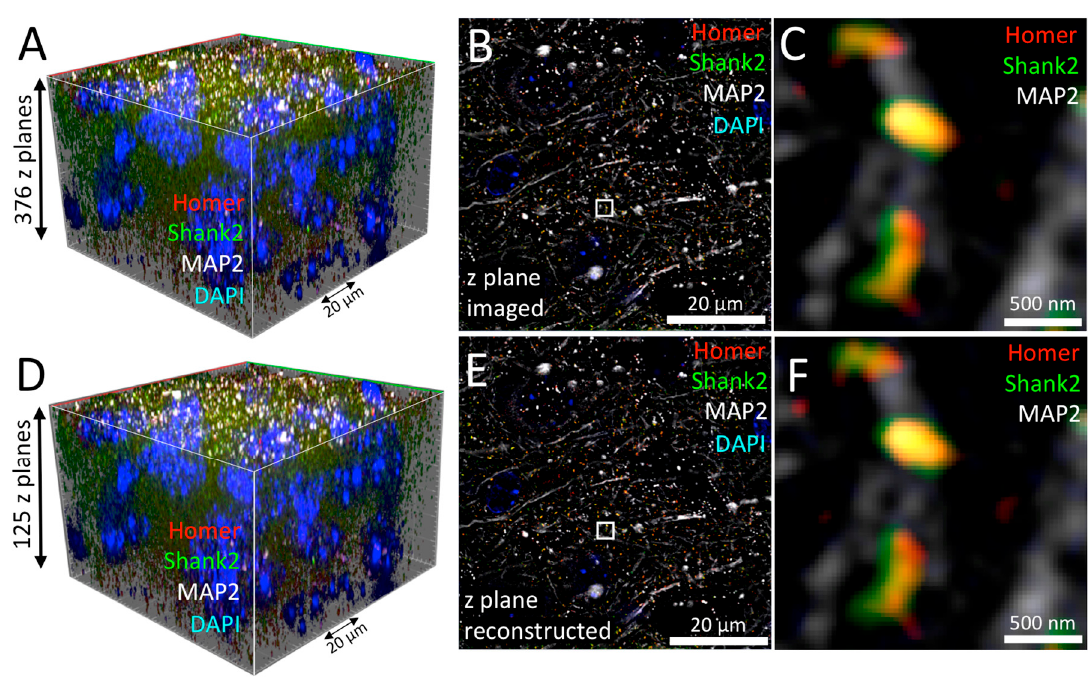
Figure 7. Lattice-SIM Leap reconstruction in tissue imaging. ( A ) A 90 × 90 × 50 ( x / y / z ) µ m 3 3D region of mouse brain immunofluorescently labeled with antibodies against Homer (red), Shank2/ProSAP1 (green) and MAP2 (white) was imaged using Lattice-SIM microscopy. DNA was counter-stained with DAPI (blue). A single optical section of the image stack is shown in B . ( C ) Enlarged view of a selected region (white box) of the image in B . ( D ) Leap reconstruction of the dataset shown in ( A ) after extraction of only every 3rd optical section. ( E ) Single optical section after reconstruction applying the Leap algorithm. ( F ) Enlarged view of a selected region (white box) of the image in E .